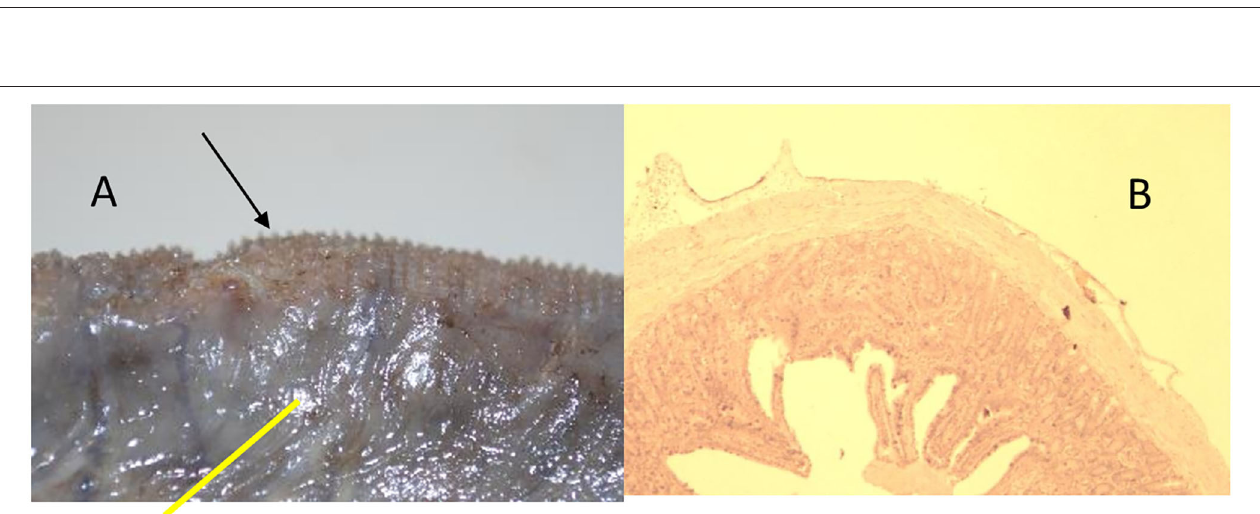
FIGURE 6 | Animal 3, − 80 mmHg. (A) Histology small intestine from the patch area. Extensions with serosa, subserosa, and lamina muscularis propria. Extended vessels in the lamina muscularis propria with intact structure (no rupture). (B) Histology from the non-patch area. Smooth surface.